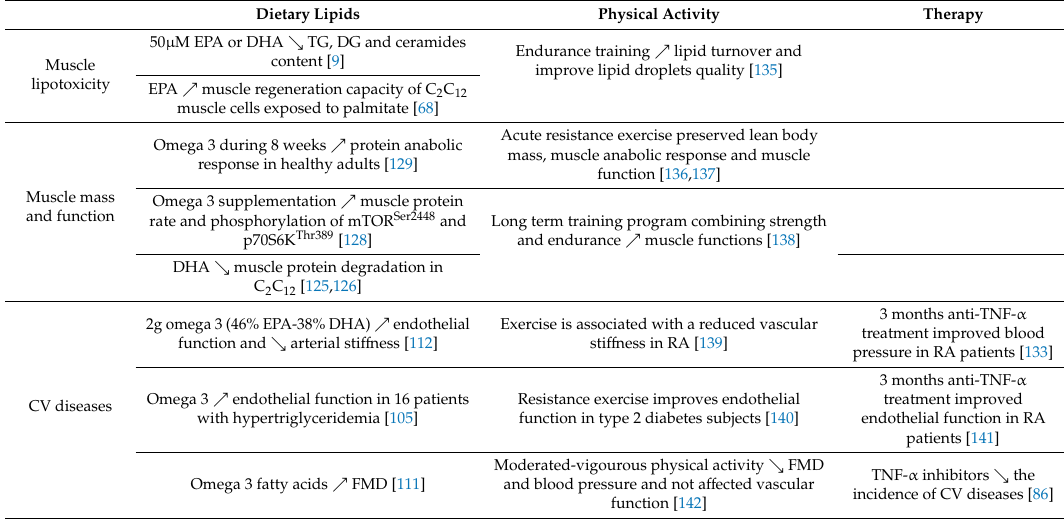
Table 2. Cont. Dietary Lipids Physical Activity Therapy Endurance training (cid:37) lipid turnover and Muscle improve lipid droplets quality lipotoxicity